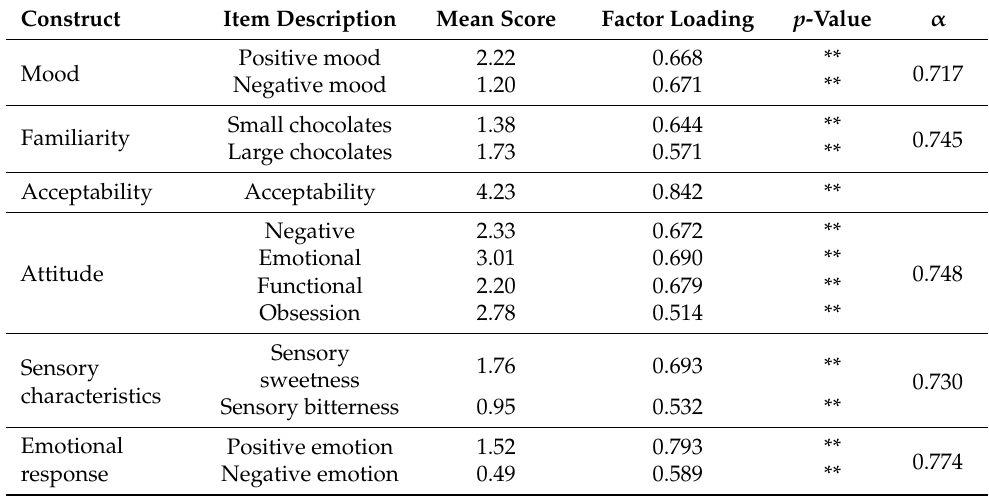
Table 2. Respondents’ mean score, factor loadings, p -values and Cronbach’s alpha ( α